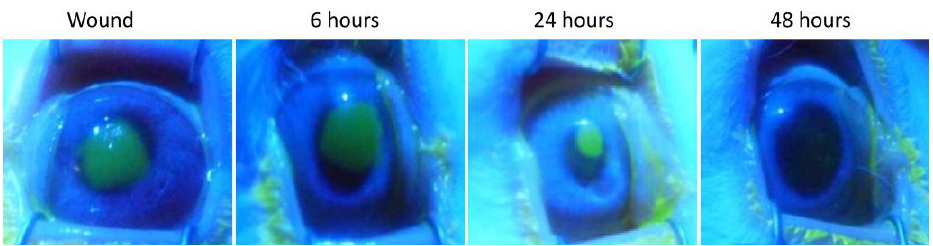
Figure 4. Fluorescent staining images, wherein the corneal epithelium wound appears in bright green upon illumination by blue cobalt light. It can be observed the evolution of the healing process along the time.